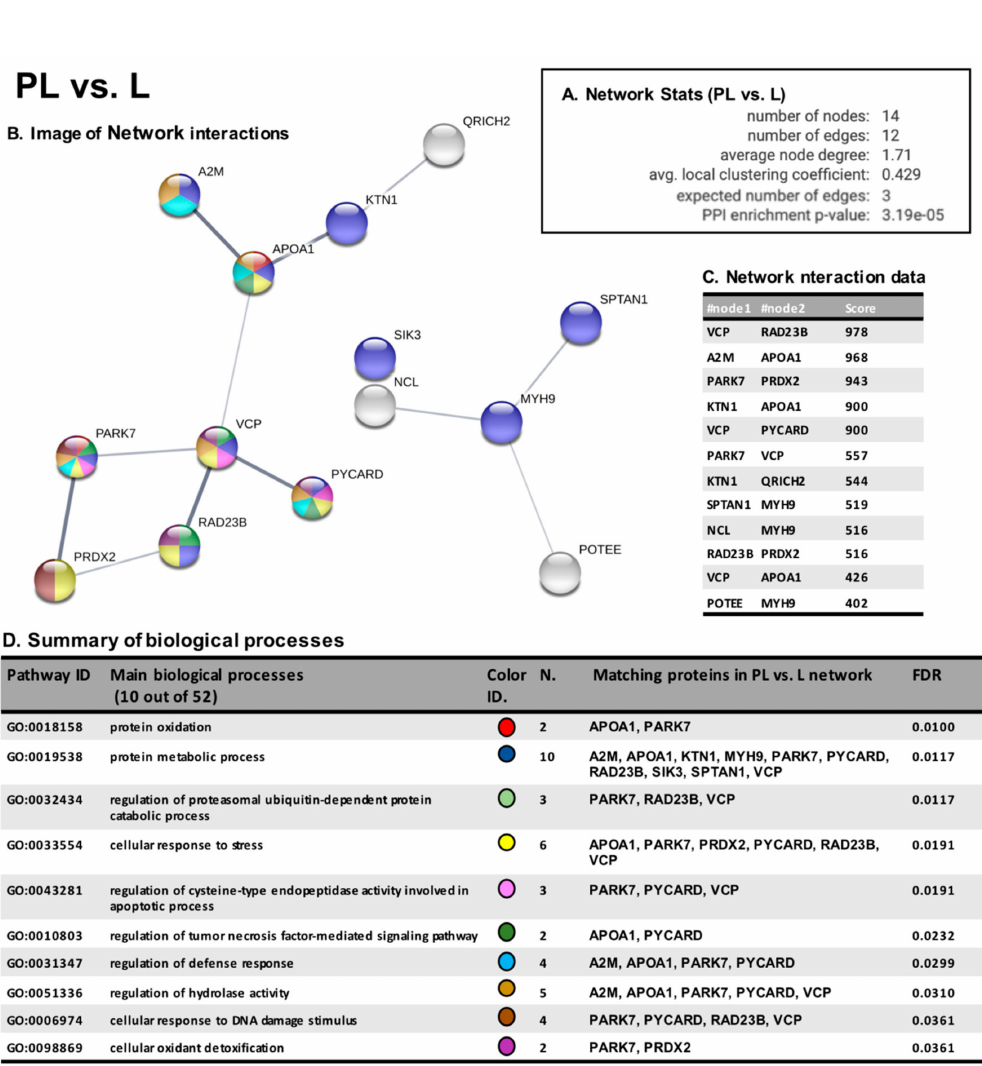
Figure 6. STRING analysis PL vs. L. Panel A : Network statistics reporting data concerning the number of nodes and edges, the average node degree, the average local clustering coe ffi cient, the expected number of edges and the PPI enrichment p -value. Panel B : Network interaction image showing nodes and edges between the proteins identified. The thickness of the line indicates the strength of the interaction between the proteins. The colours of the sphere indicate the biological processes to which the protein belongs. Panel C : Network interaction table reporting all the significant interactions (min 0.4) between the protein of the PL vs. NPE network. Panel D : Biological process table reporting the main pathways to which the protein of the networks belongs. For each biological process identified, the corresponding GO pathway, the number and identity of proteins and the false discovery rate is